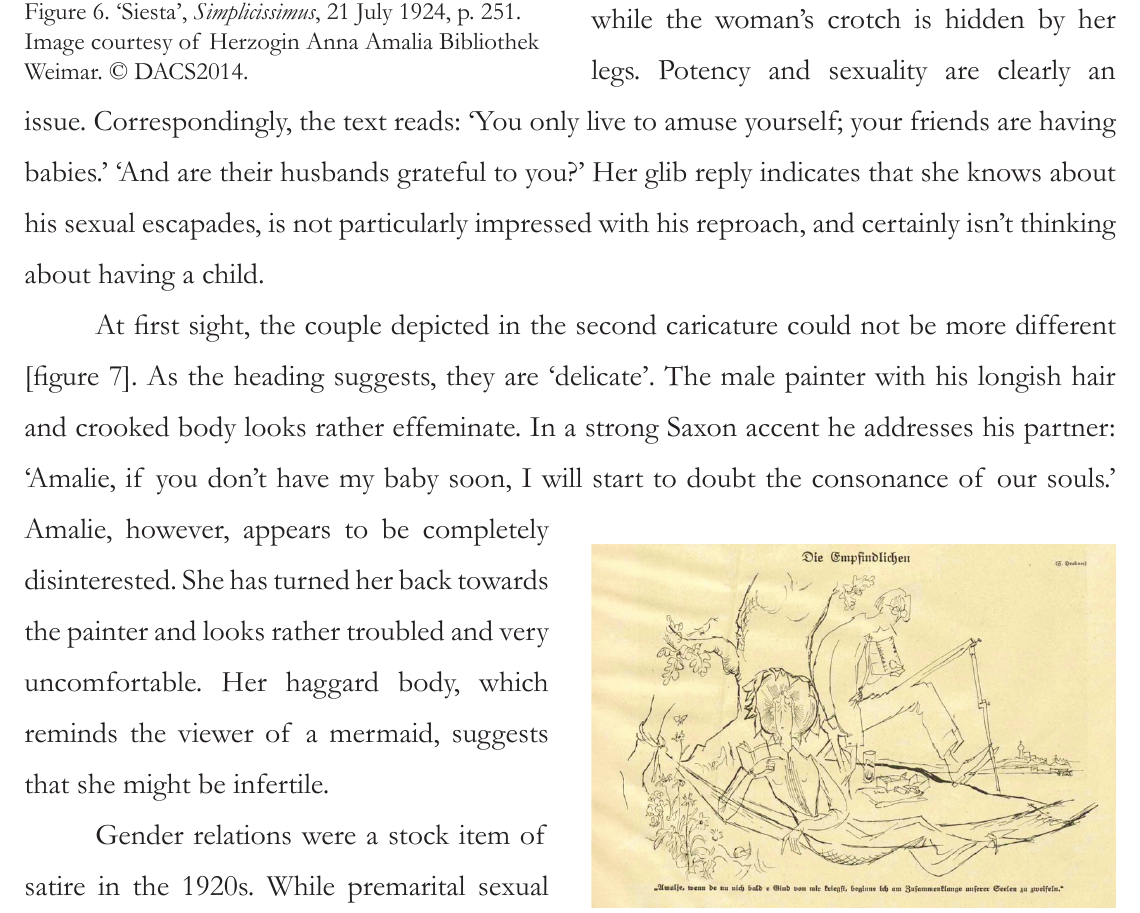
Figure 7. ‘Die Empfindlichen (Delicate people), Simplicissimus , 29 September 1924, p. 371. Image courtesy of Herzog Anna Amalia Bibliothek